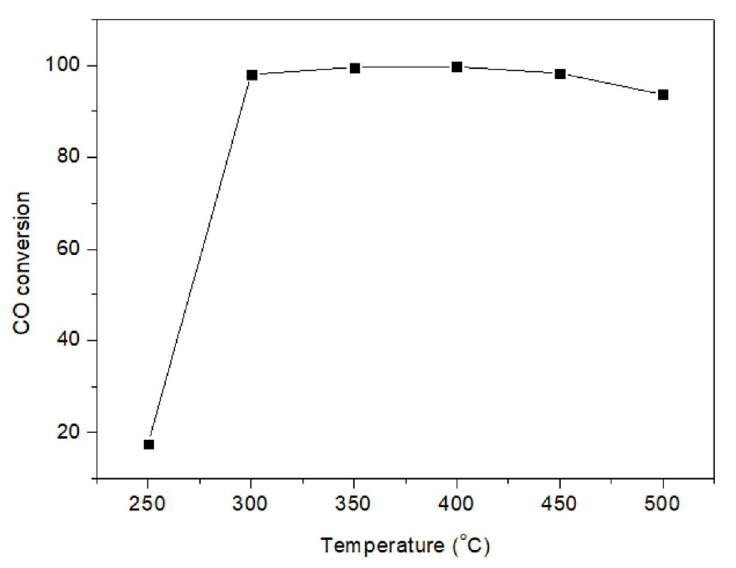
Figure 3. High temperature stability test for sample NCTS(ad), reaction condition: H 2 /CO = 3, GHSV = 7500 h −1 , atmospheric pressure.